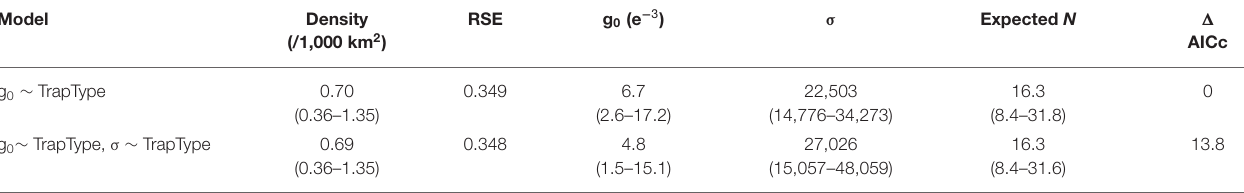
TABLE 2 | Grizzly bear density model results, with density modeled as a homogeneous surface in both models.